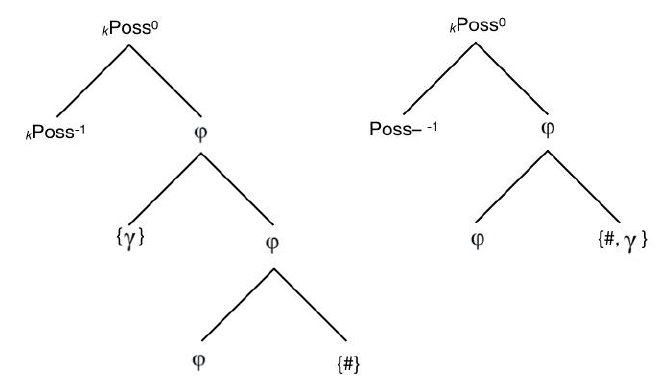
Figure 4. Alternative sub-atomic composition of the Asturian